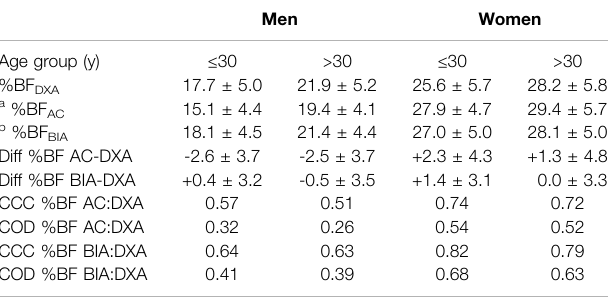
TABLE 4 | Within-subjects effects between %BF calculation methods and age